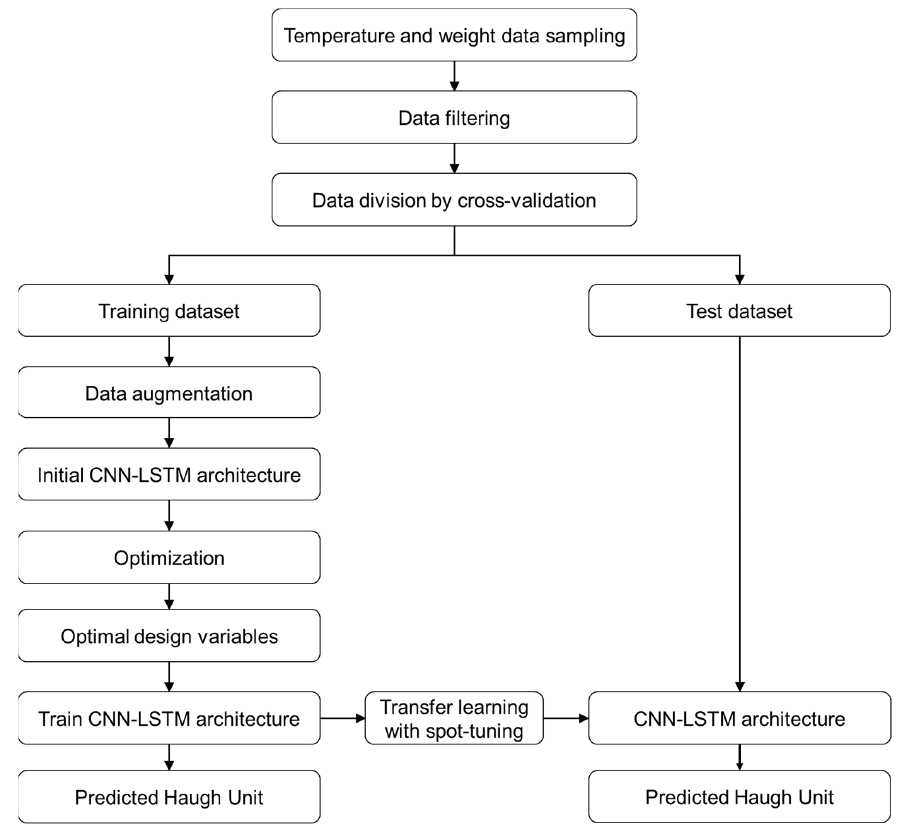
Figure 7. The flowchart of the transfer-learning-based HU prediction model.